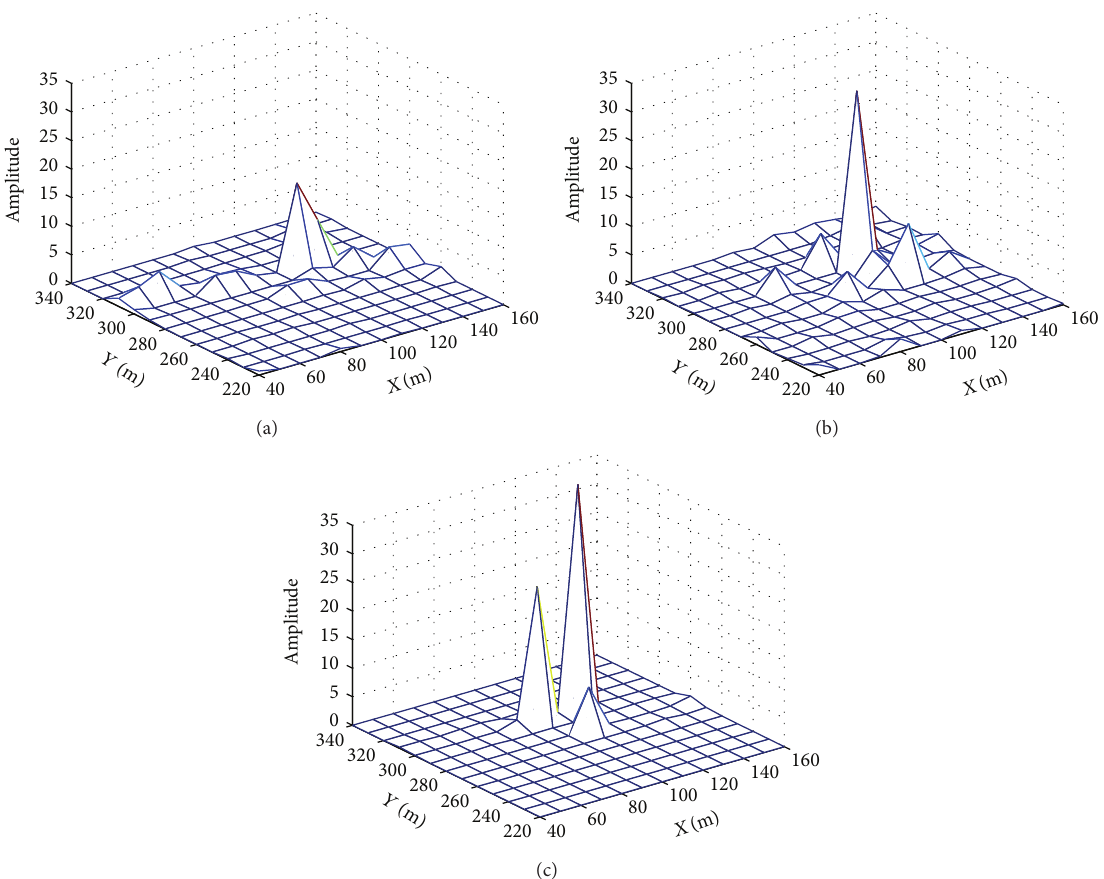
Figure 5: Comparison of reconstructed target reflection coefficients in dense targets case. SNR = 10dB, grid distance is 10m. (a) Group-Lasso, (b) Group-MP, and (c) BSBL- ℓ 1 exploiting correlation.